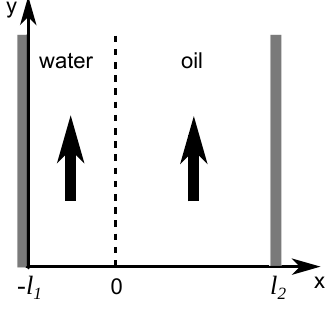
Figure 3. Graphical schematic representation of oil and water in a microchannel. The interface between both liquids is located at position x =